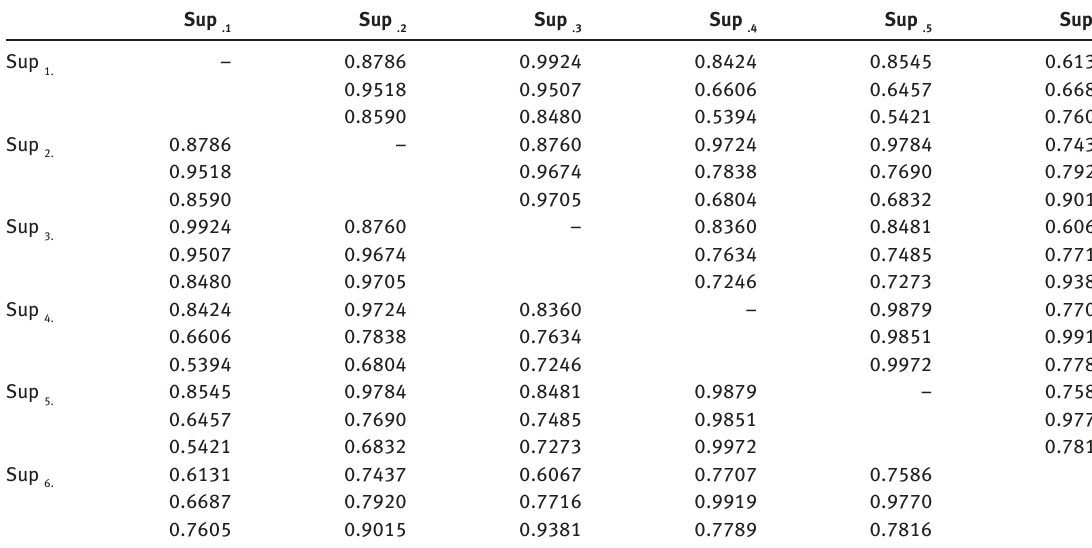
Table 8: Supports between Rows of R